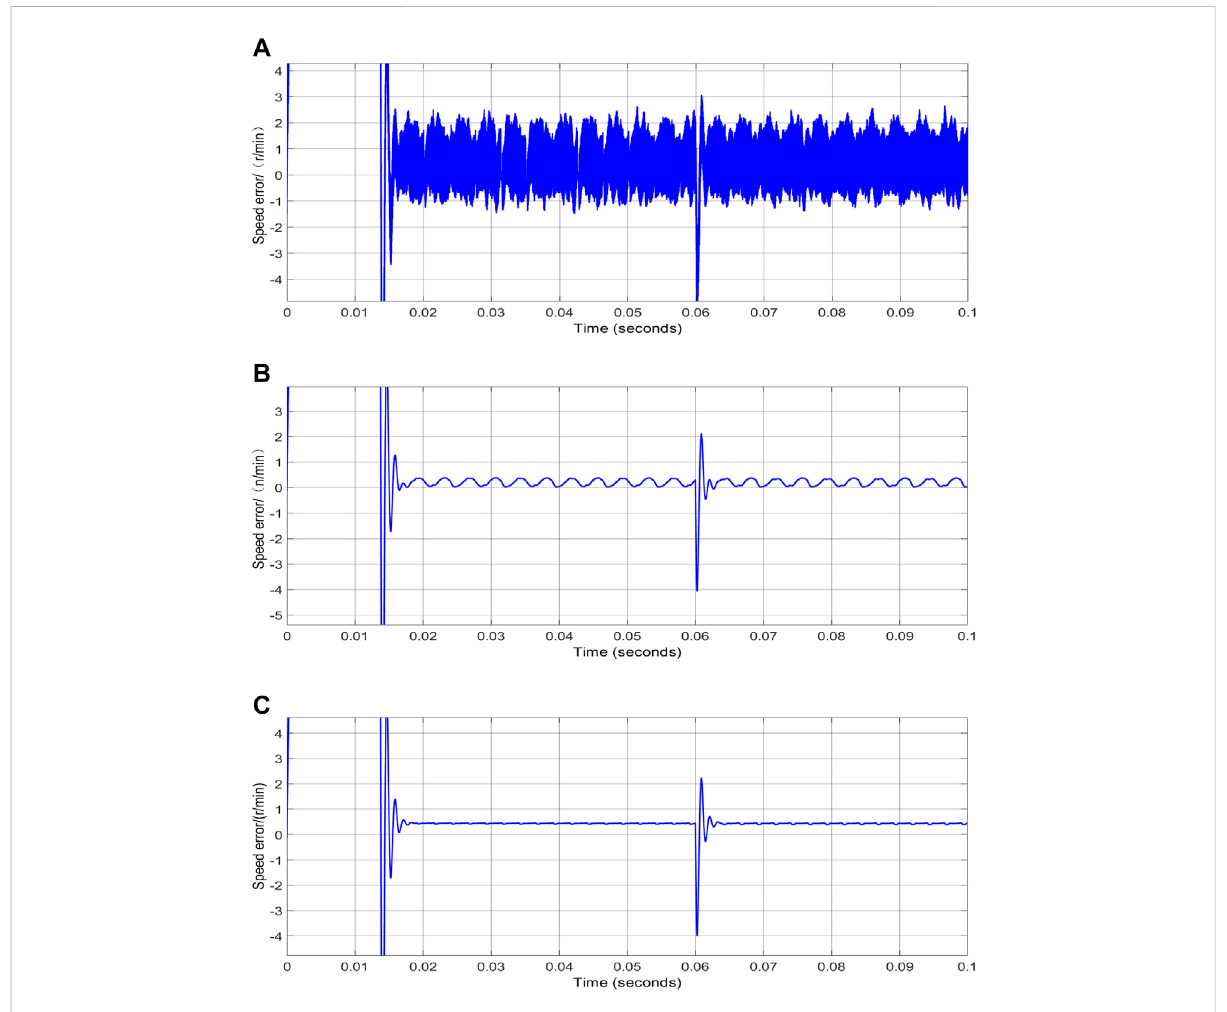
FIGURE 7 (A) Rotational speed error of the SMO based on the sgn function; (B) rotational speed error of the SMO based on the sigmoid function; (C) rotational speed error of the SMO based on the piecewise power